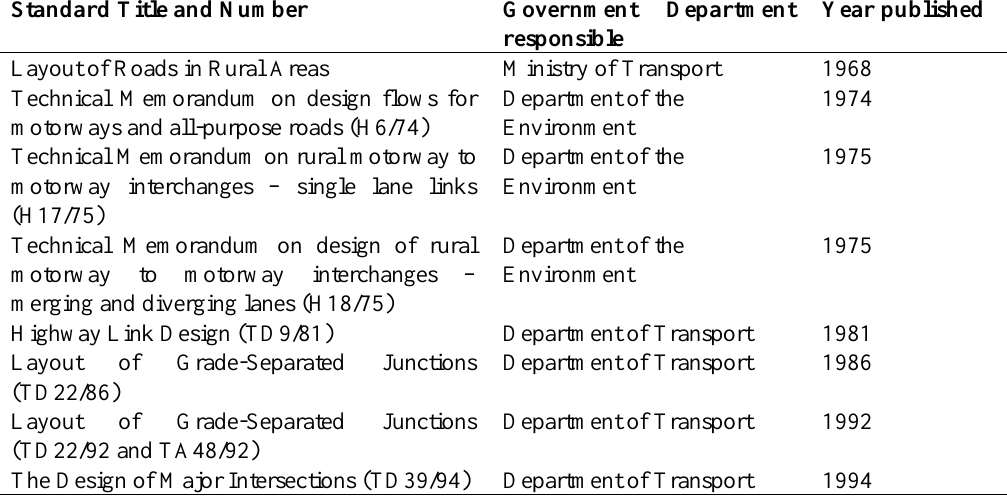
Table 1. Selected UK standards for motorway diverges